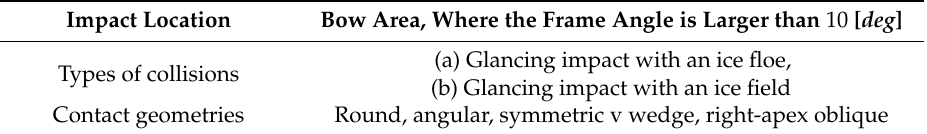
Table 2. Collision scenarios proposed by Popov et al. [9] and Daley